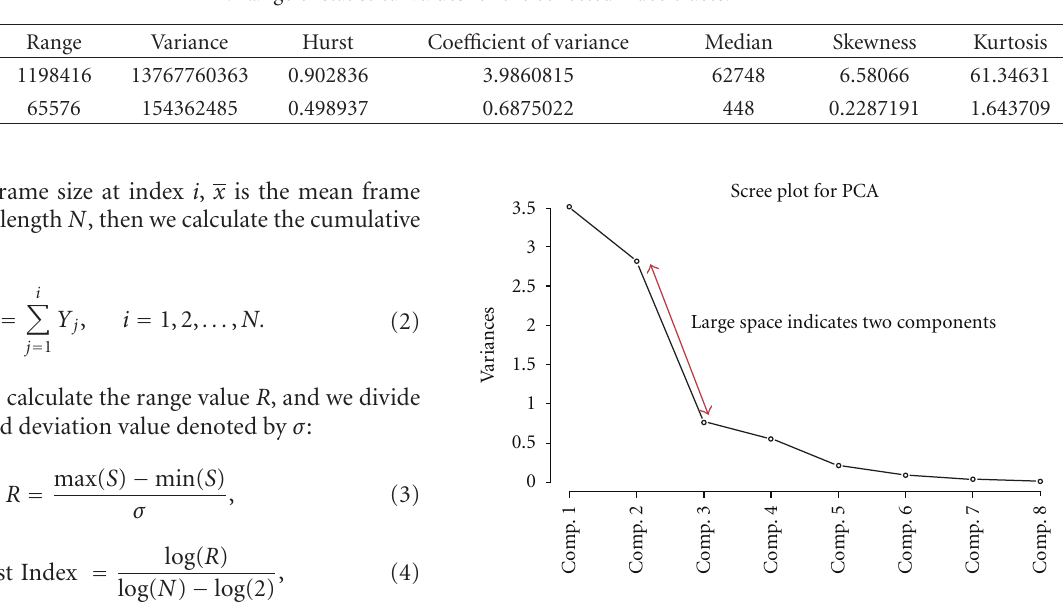
Table 2: Range of statistical values for the collected video traces.